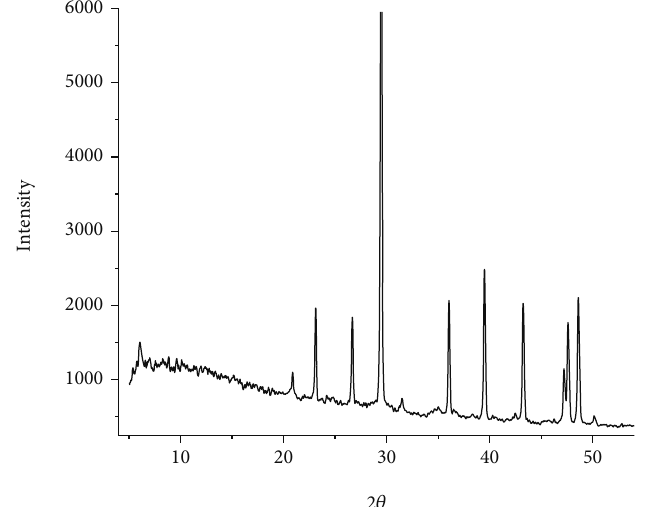
Figure 1: XRD pattern of the GC clay sample.